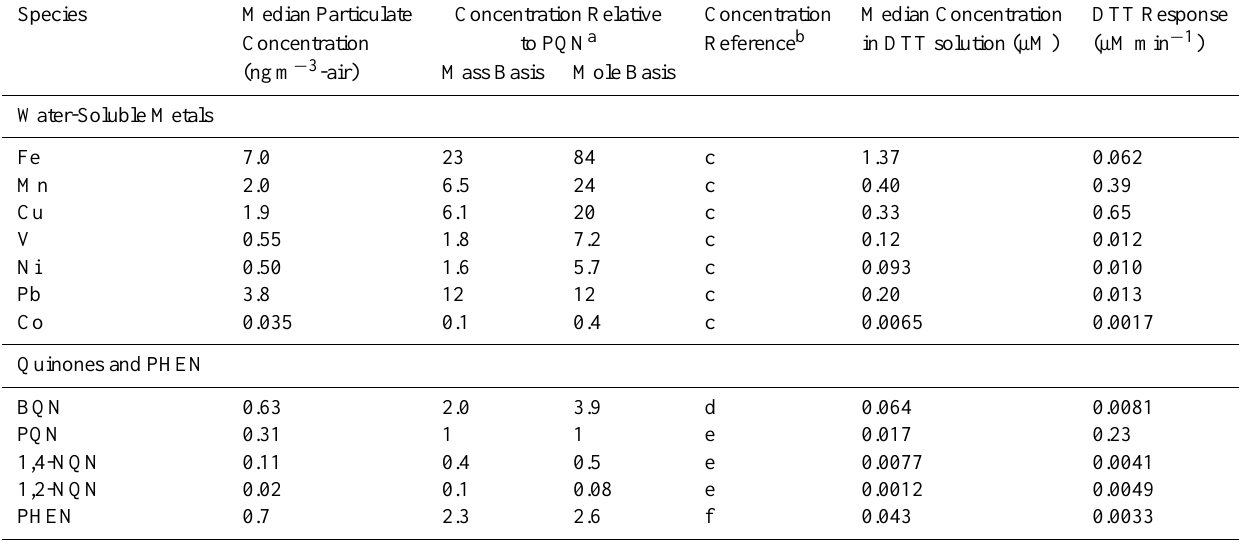
Table 2. Median concentrations of water-soluble metals and total organics in ambient fine particles and their corresponding DTT solution concentrations and DTT responses. Median